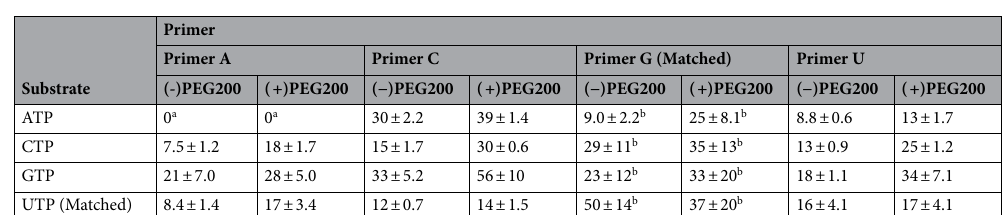
Figure 2. Polymerization in the absence of PEG200 by T7 RNAP with ( a ) primer A, ( b ) primer C, ( c ) primer G, ( d ) primer U, and in the presence of PEG200 with ( e ) primer A, ( f ) primer C, ( g ) primer G, ( h ) primer U. Positions of products ( n + 1, 2, 3, or 4, where n is the primer length) are indicated. Conditions: 0.5 μM T7 RNAP, 0.5 μM each RNA primer, 0.5 μM template RNA with 100 μM each NTP in 50 mM Tris–HCl (pH 8.0), 10 mM MgCl 2 , and with or without 20wt% PEG200 at 25 °C for 12 h. The results using primer G are the original data of PAGE, which was not shown in the previous report 26 . Full-length gels are presented in Supplementary Information Figure S7.